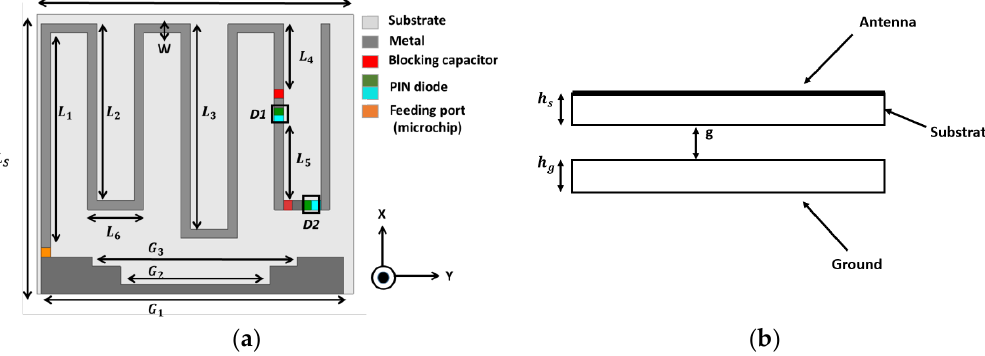
Figure 1. Geometry of frequency switchable RFID tag antenna ( a ) Top view ( b ) side view. Table 1. Design Parameters of proposed antenna.